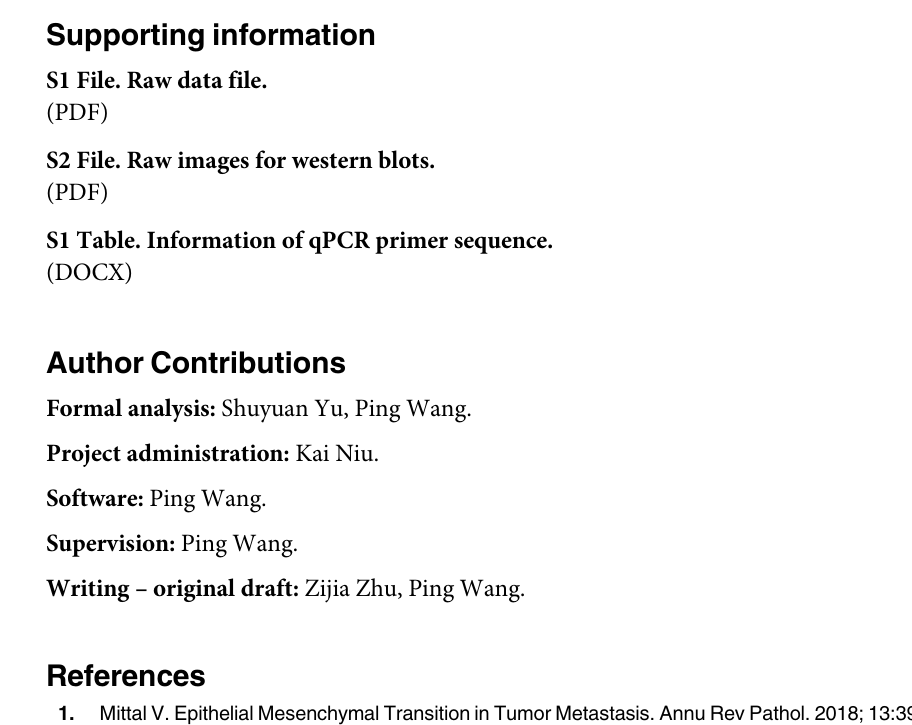
S1 Table. Information of qPCR primer sequence.